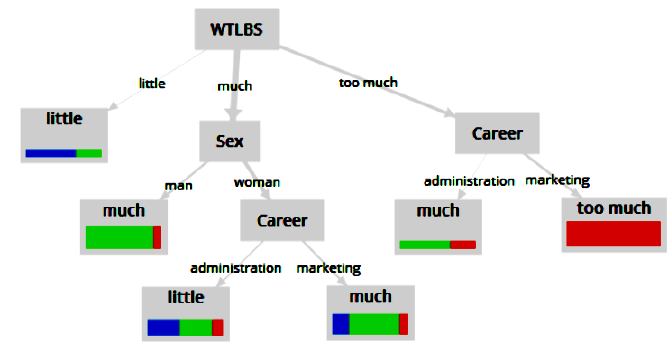
Figure 3. The predictive model 1 on the use of the web application for the teaching-learning process on bank savings (source: created by authors)